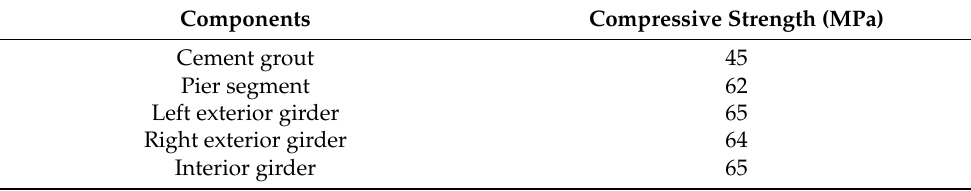
Table 2. Compressive strengths of individual